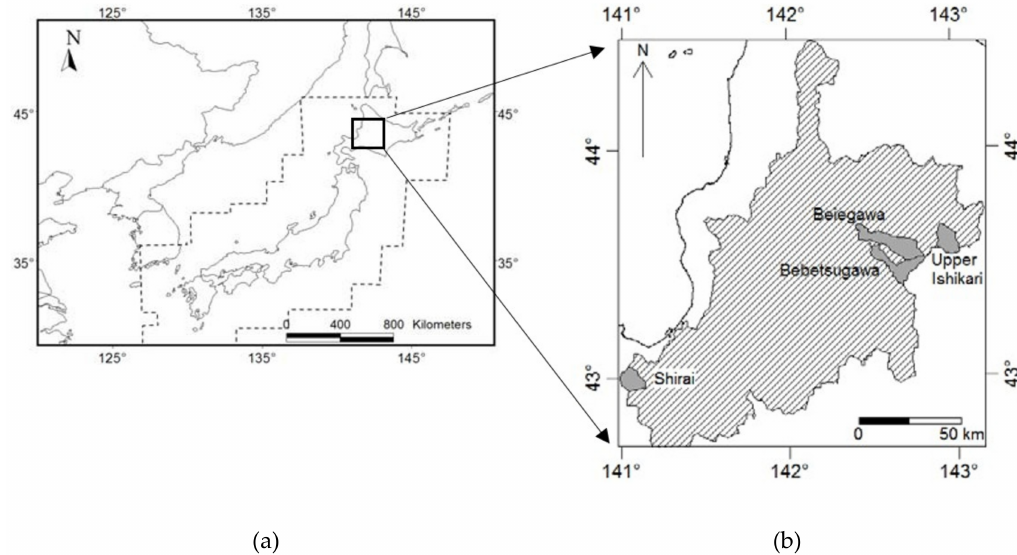
Figure 2. ( a ) The location of study area in the islands of Japan; ( b ) Ishikari river basin, Hokkaido bounded as shaded area. The grey areas represent Shirai, Bebetsugawa, Beiegawa, and Upper Ishikari river